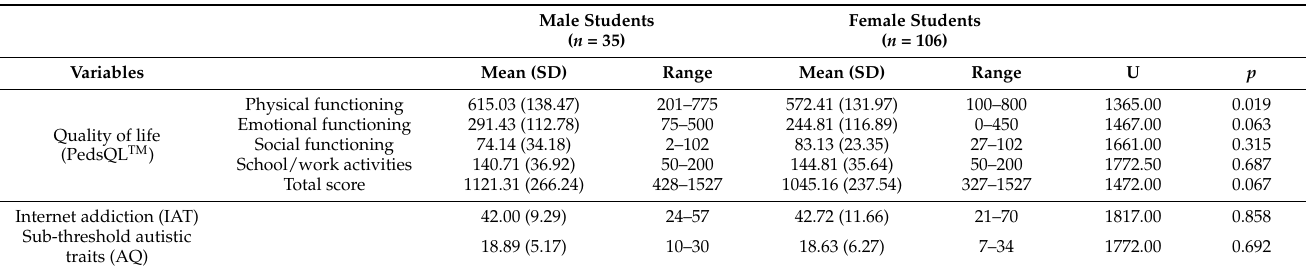
Table 1. Descriptive data for quality of life (PedsQL TM ), internet addiction (IAT), and sub-threshold autistic traits (AQ) by gender, and results of the statistical comparisons (Mann-Whitney tests). Significant results are reported in bold.